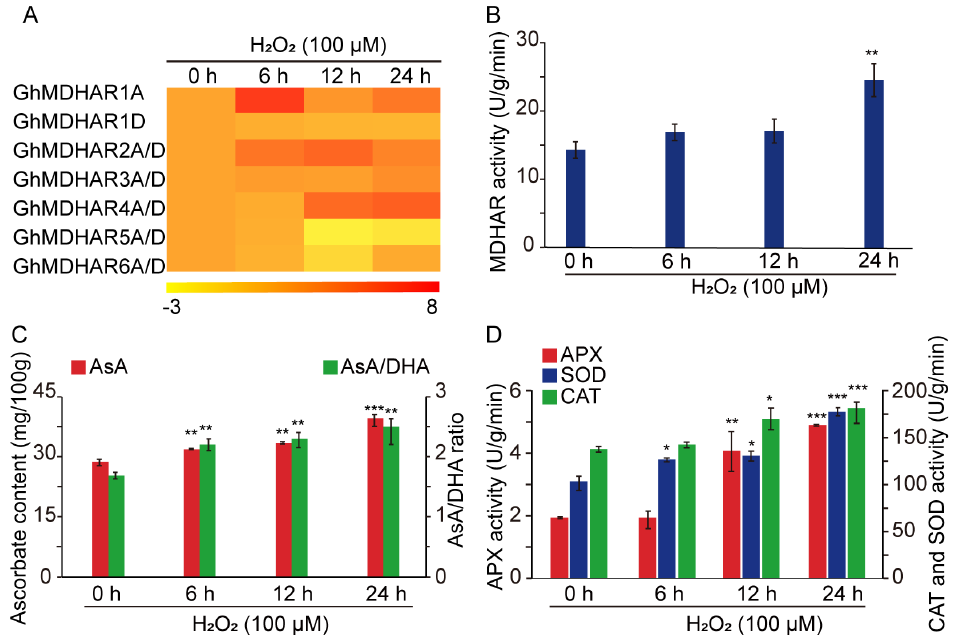
Figure 7. Analyses of GhMDHAR expression and AsA antioxidant enzyme activity under H 2 O 2 treatment. The cotton leaves treated by 100 µ M H 2 O 2 for 6, 12 and 24 h were applied for the determinations. ( A ) Heatmap of GhMDHARs expression levels detected by qRT-PCR. The colors of yellow, orange, and red indicate low, moderate, and high expression levels respectively. GhUBQ7 gene was used as internal control for normalization and the untreated 0-h expression level was artificially set to 1. R package was utilized to generate the heatmap. ( B ) MDHAR enzyme activity analysis. ( C ) Measurement of AsA content and AsA/DHA ratio. ( D ) Activity analysis of AsA antioxidant enzymes. The activities of enzymes of ascorbate peroxidase (APX), superoxide dismutase (SOD) and catalase (CAT) were measured. The values of untreated 0-h materials were used as reference for statistical difference analysis, with *, **, and *** to present the differences at 0.05, 0.01 and 0.001 levels, respectively.